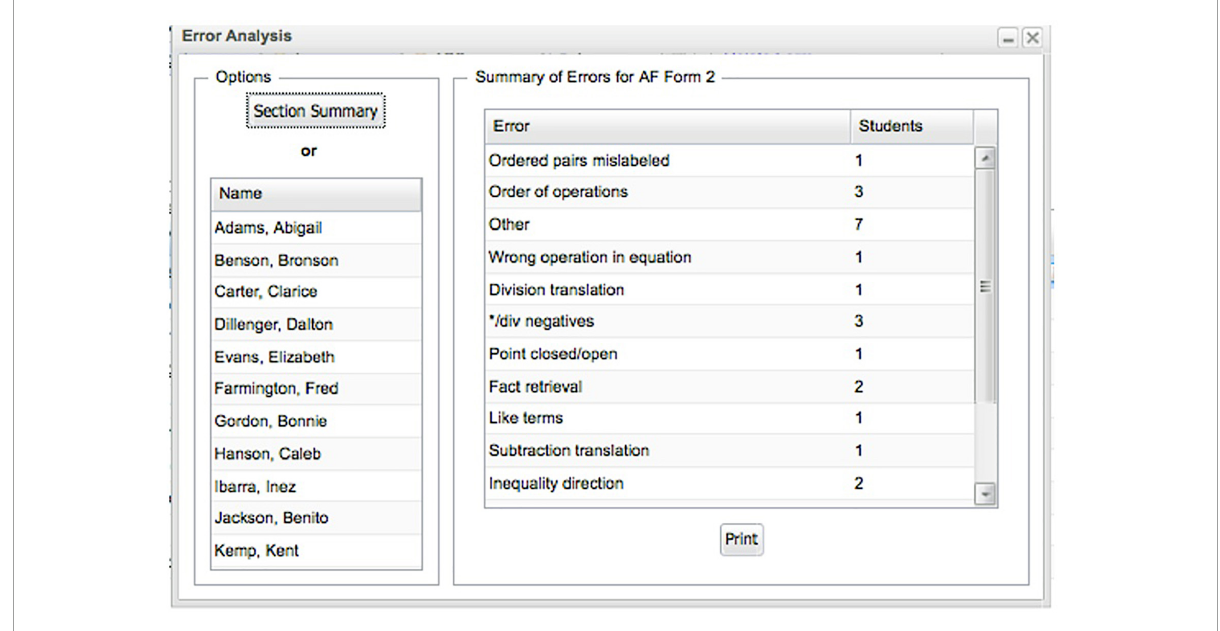
FIGURE4 Sample report for common errors across